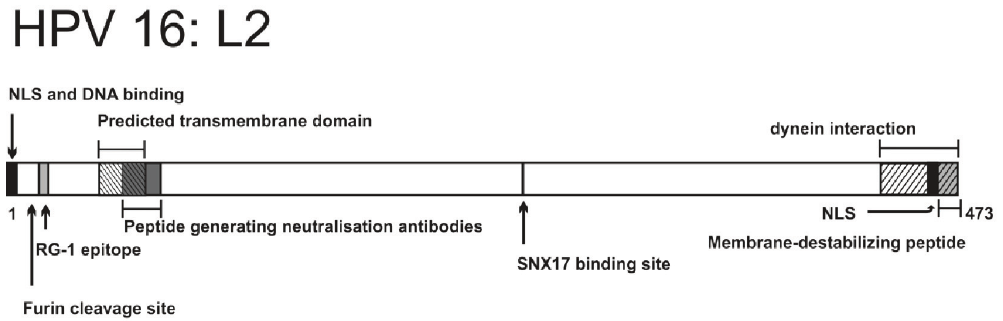
Figure 4. Schematic representation of HPV16 L2 structural and functional features (NLS—Nuclear Localization